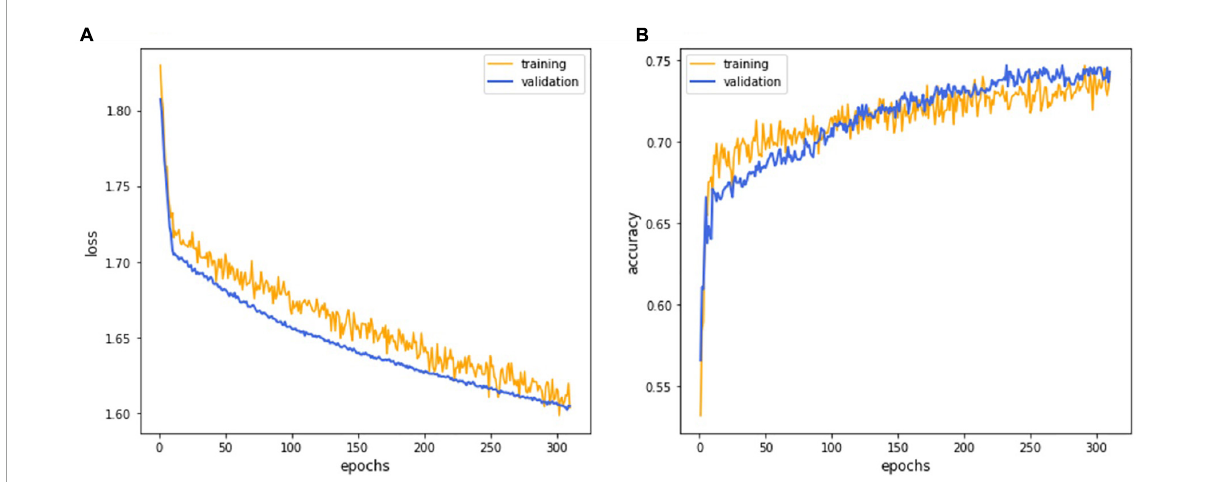
FIGURE4 The deep learning model training curve. The CNN model EfficientNet training process revealed that iterations attained lower loss (A) and higher accuracy (B) as the model underwent successive iterations with the 252nd epoch representing the best performance.